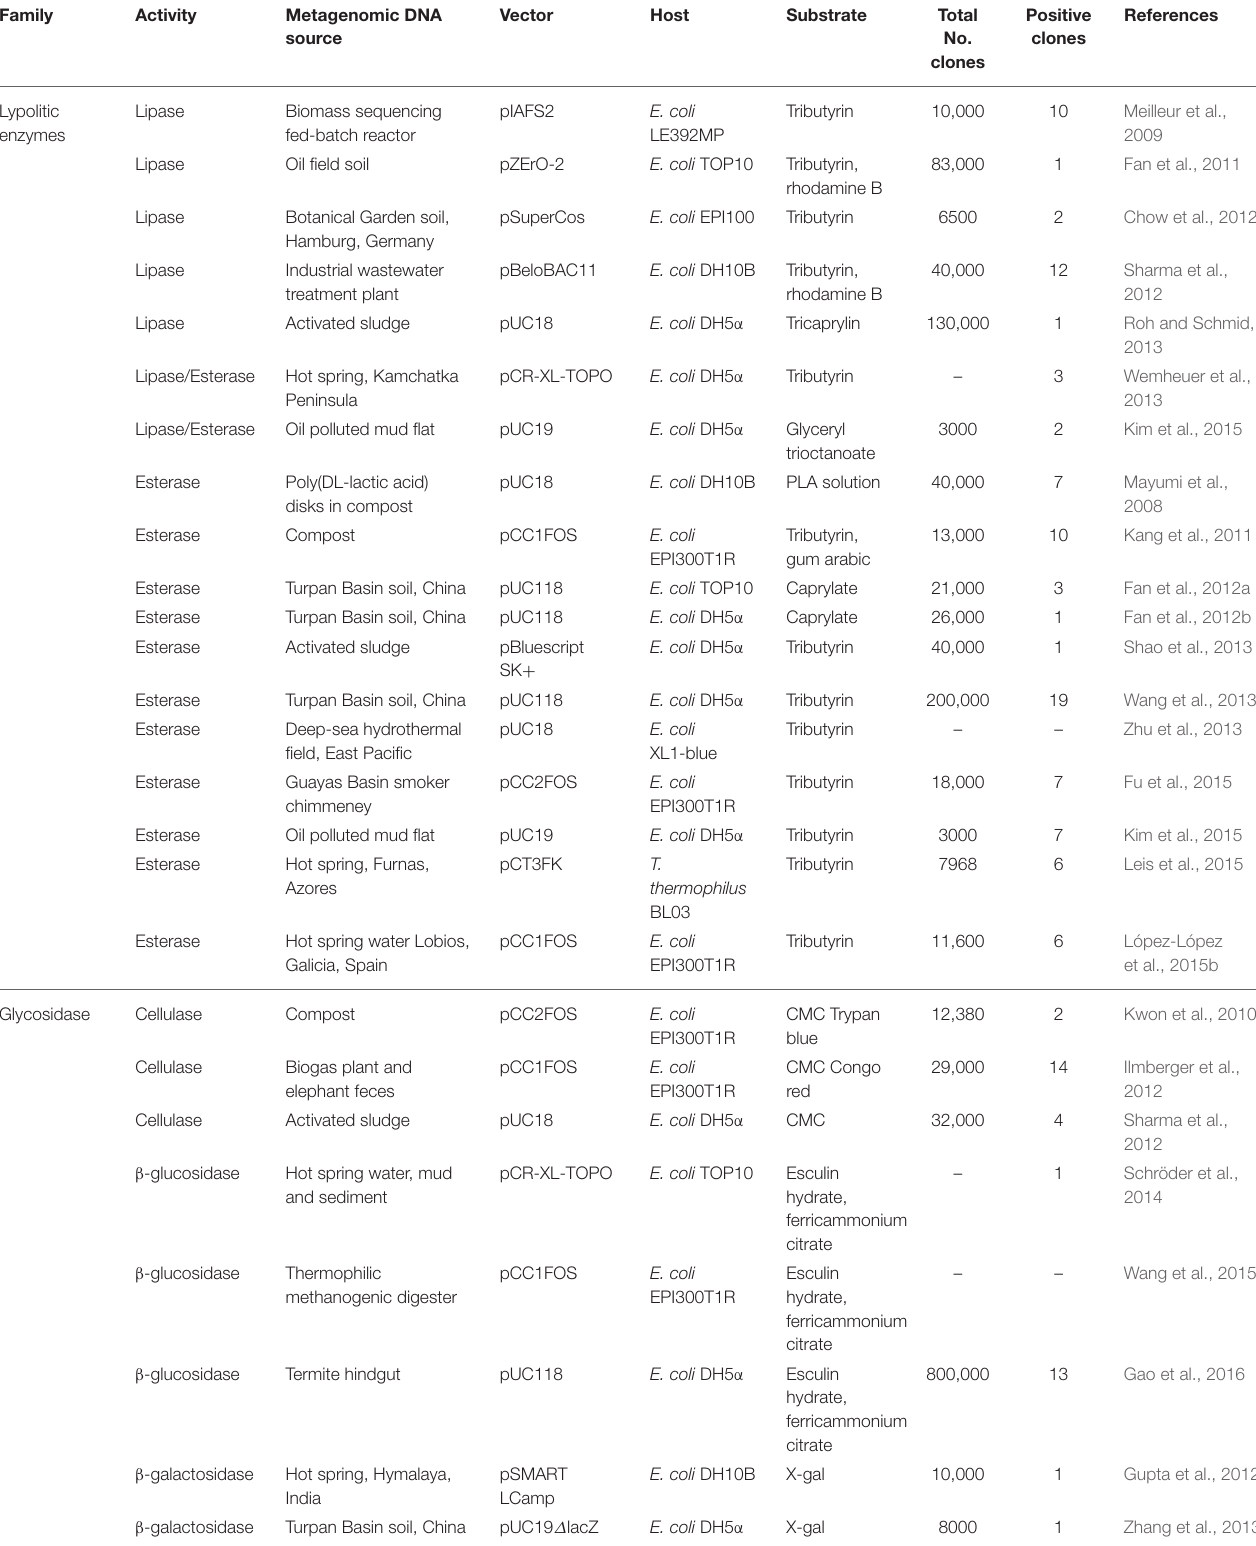
TABLE 3 | Examples of thermozymes obtained by functional metagenomics.